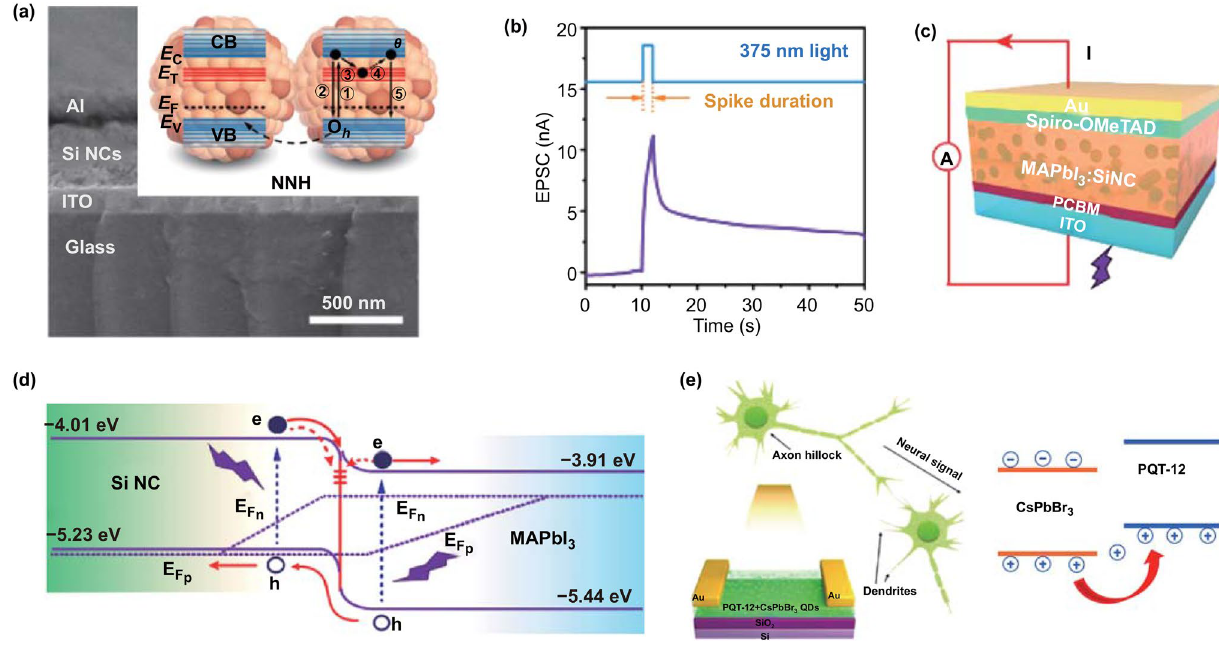
Fig. 6 a Schematic of the silicon-based vertical two-terminal synaptic device; the inset shows the generation, capture, and release process of electrons. b EPSC of silicon-based vertical synaptic devices in response to 375-nm spike. a , b Reproduced with permission from Ref. [20]. c Schematic of an photoelectronic synaptic device with the multilayer structure of ITO/PCBM/MAPbI 3 :Si NC/Spiro-OMeTAD/Au on glass. d Schematic of band alignment between Si NCs and MAPbI 3 and the behavior of the generation, trapping, and release mechanism of the carriers. Electrons and holes are denoted by filled and empty circles, respectively. Traps at the interface between MAPbI 3 and Si NCs are indicated by short solid lines. c , d Reproduced with permission from Ref. [108]. e Schematic of the hybrid structure of CsPbBr 3 and PQT-12-based synaptic device and its working mechanism. Reproduced with permission from Ref.